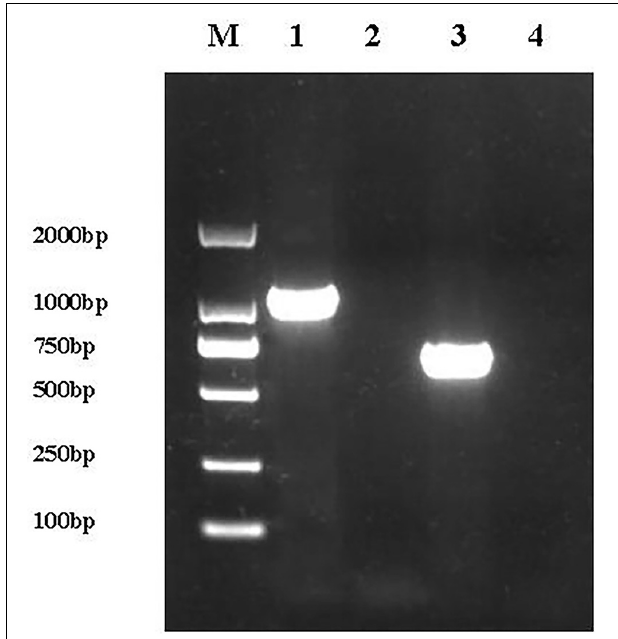
FIGURE 1 | Verification of E. coli ReJW4073 and E. coli ReJW4074 construction. PCR products were detected by 2% agarose gel electrophoresis. Lane M represents the 2,000 bp DNA marker, lane 1 contains the PCR product from E. coli ReJW4073, lane 2 contains the PCR product from E. coli JW4073, lane 3 contains the PCR product from E. coli ReJW4074, and lane 4 contains the PCR product from E. coli JW4074.